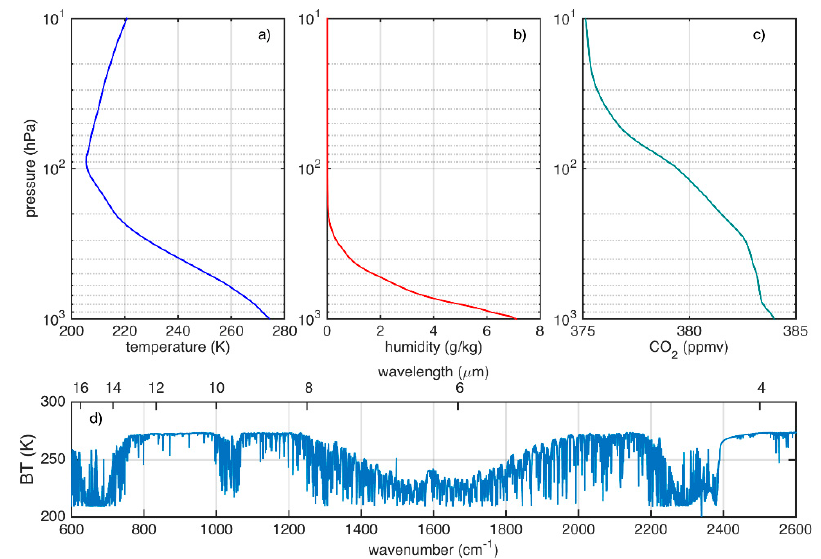
Figure 2. The atmospheric ( a ) temperature, ( b ) moisture, ( c ) CO 2 profiles, and ( d ) the brightness temperature (BT) spectrum simulated from the atmospheric profiles. The base CO 2 profile is around 380 ppmv. The spectral resolution is 0.625 cm − 1 in this BT spectrum.